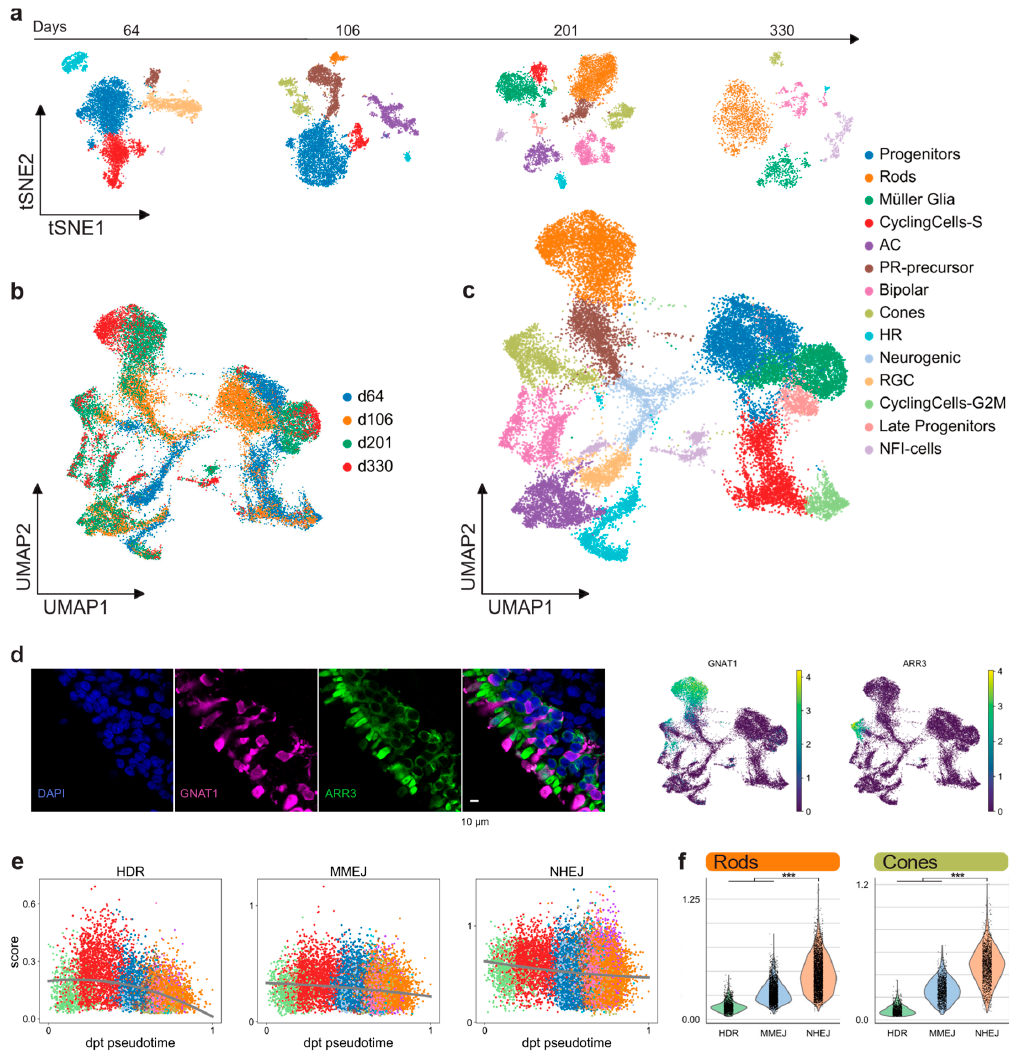
Figure 3. hiPSC-derived retinal organoids. ( a ) hiPSC-derived organoid sequenced cells visualized in two t-sne dimensions, showing different cell-type composition at four different time points. ( b ) 26,700 quality filtered cells merged together and colored by batch, visualized in two-dimensional UMAPs. ( c ) Merged retinal organoid dataset visualized in two-dimensional UMAPs and colored by annotated retinal clusters. ( d ) Immunohistochemistry indicates, after scRNA-seq analysis, the presence of distinct rod ( GNAT1 ) and cone ( ARR3 ) populations in the outer layer of the hiPSC-derived retinal organoids. ( e ) Pseudo-timed HDR, MMEJ, and NHEJ scores within the neuronal lineage of hiPSC-derived organoids. Lines represent the polynomial fit to the data. ( f ) DSB repair pathway activity scores of rods and cones in hiPSC-derived retinal